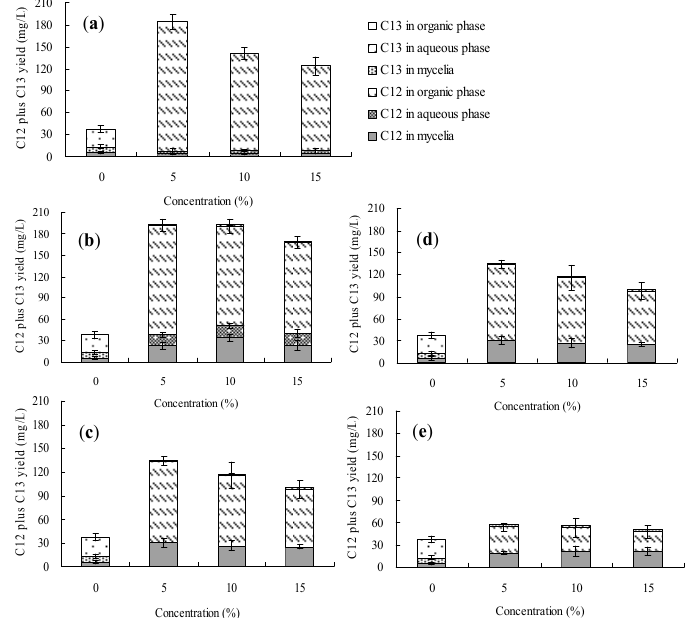
Figure 4. Effects of butyl oleate on palmarumycin production in liquid culture of Berkleasmium sp. Dzf12. Butyl oleate was applied at 0%, 5%, 10% and 15% on days 0 ( a ); 3 ( b ); 6 ( c ); 9 ( d ) and 12 ( e ) of culture, respectively. The period of culture lasted for 15 days. “C12” means palmarumycin C 12 , “C13” means palmarumycin C 13 . The error bars represent standard deviations from three independent samples.